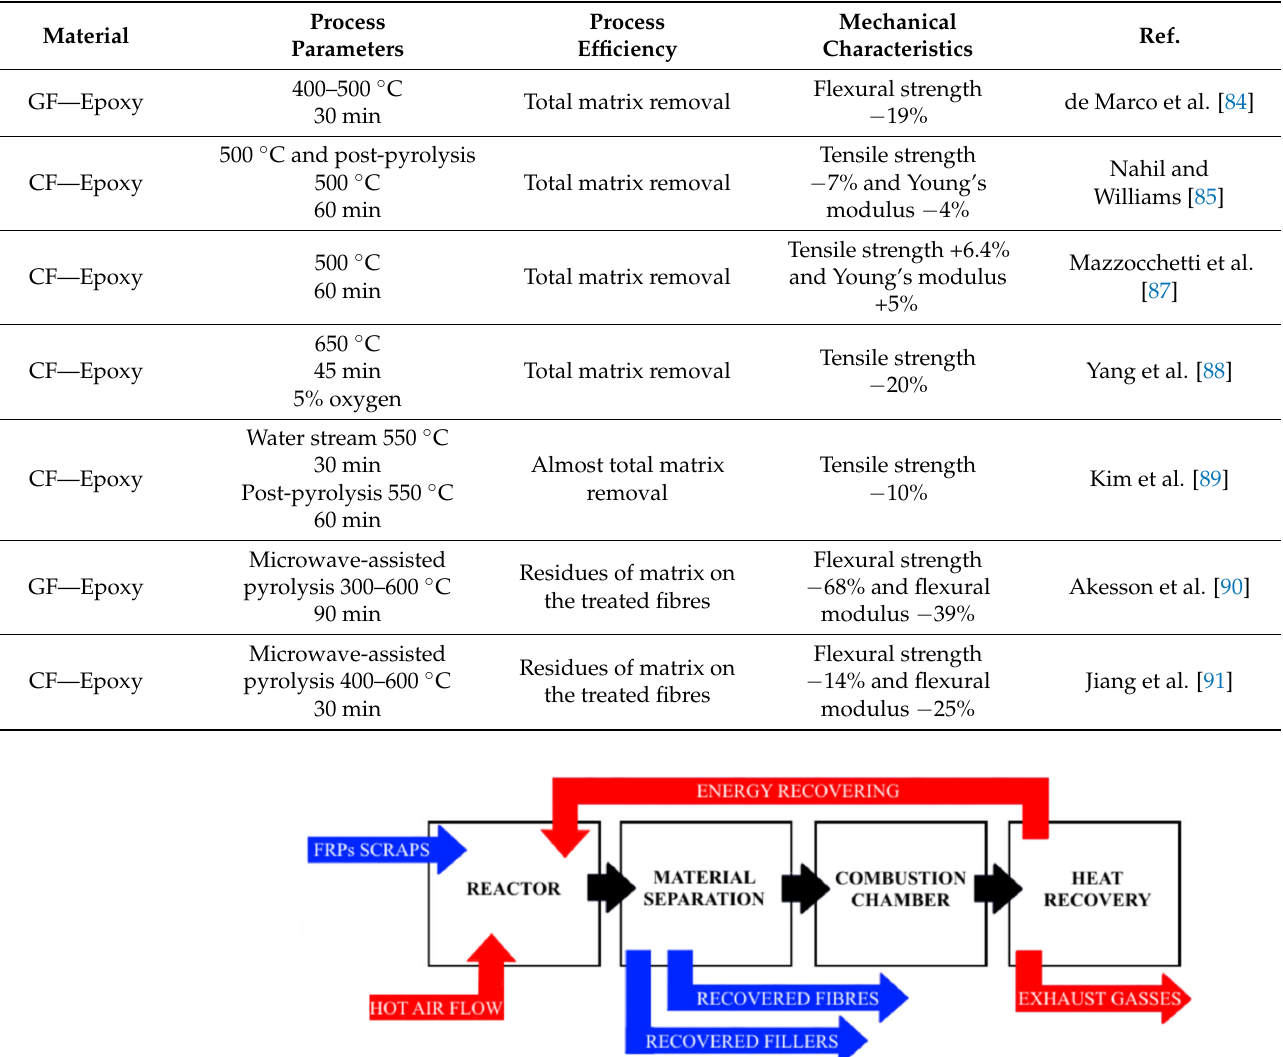
Table 4. Main results deriving from the thermal recycling process of pyrolysis.